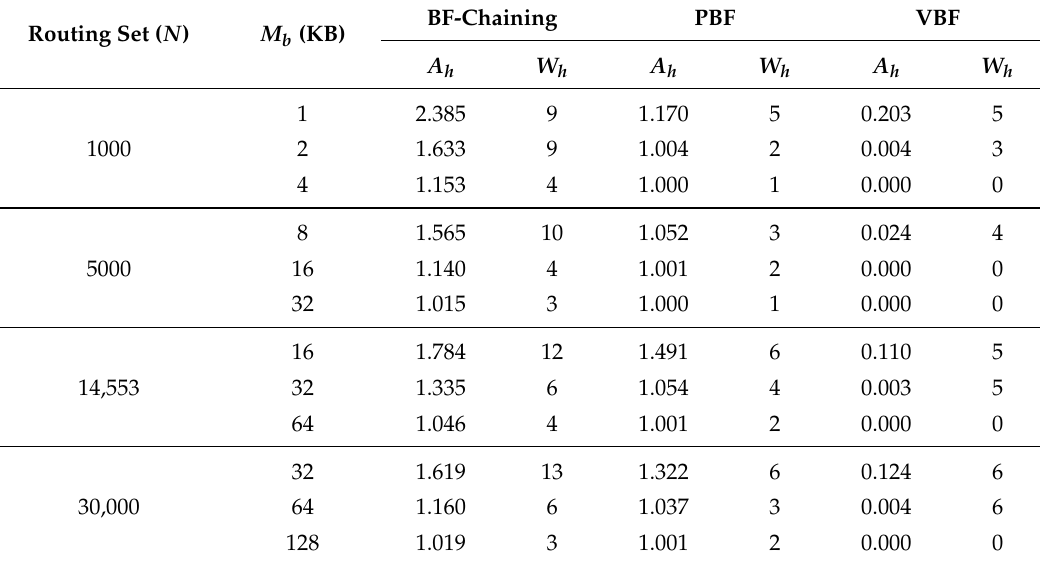
Table 7. Comparison on the number of off-chip hash table